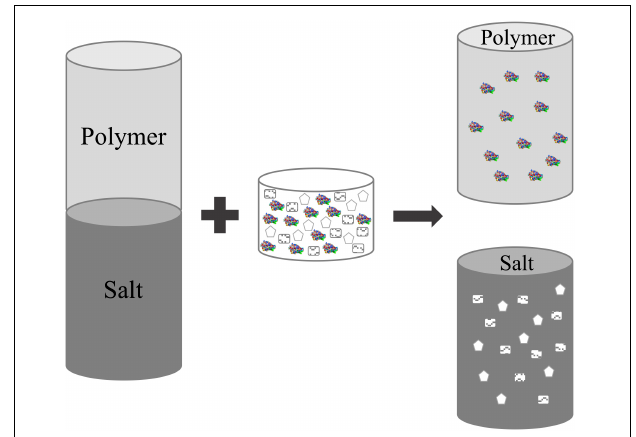
FIGURE 1 | Aqueous two-phase systems (ATPS). ATPS can be formed through the combination of two polymers or a polymer and a salt at critical concentrations. Many parameters are involved in the partition, however in general the enzyme is concentrated in one of the phases.